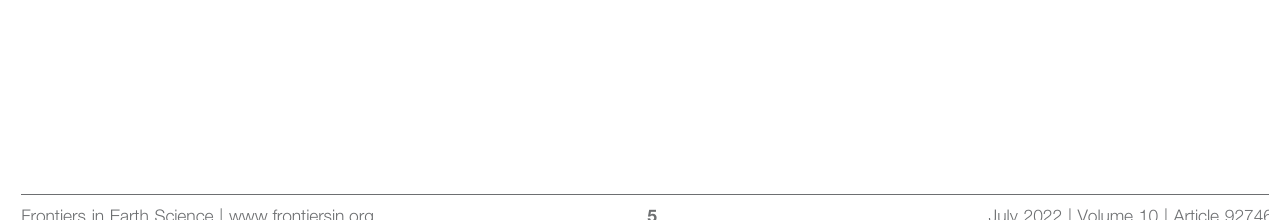
Frontiers in Earth Science |